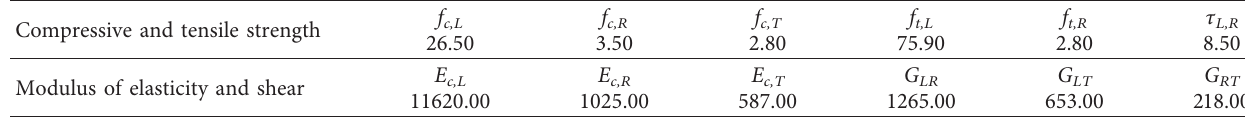
Table 2: Material parameters of wood (unit: N/mm 2 ).